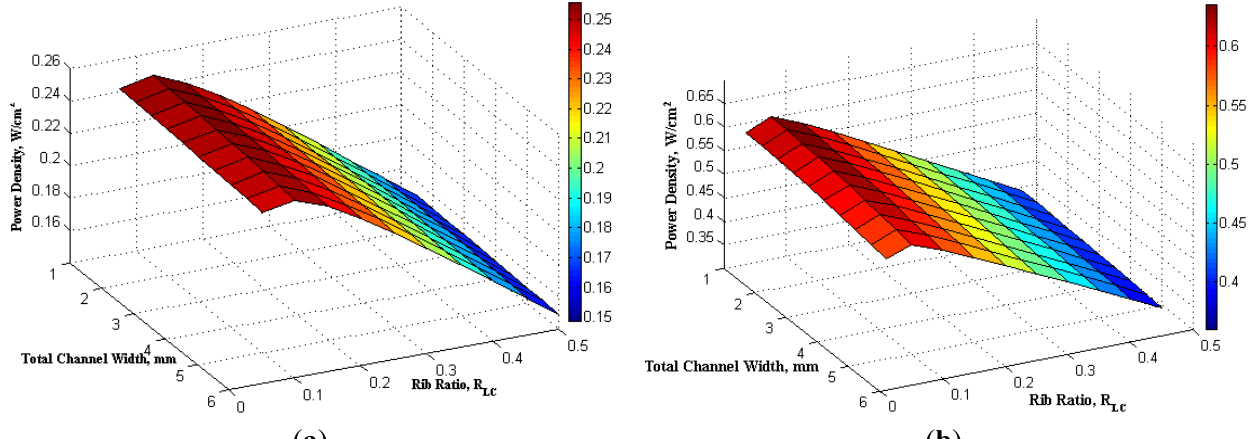
Figure 8. H-SOFC maximum power density in variation with the designs of total channel width and rib ratio ( a ) Operation temperature of 500 °C; ( b ) Operation temperature of 700